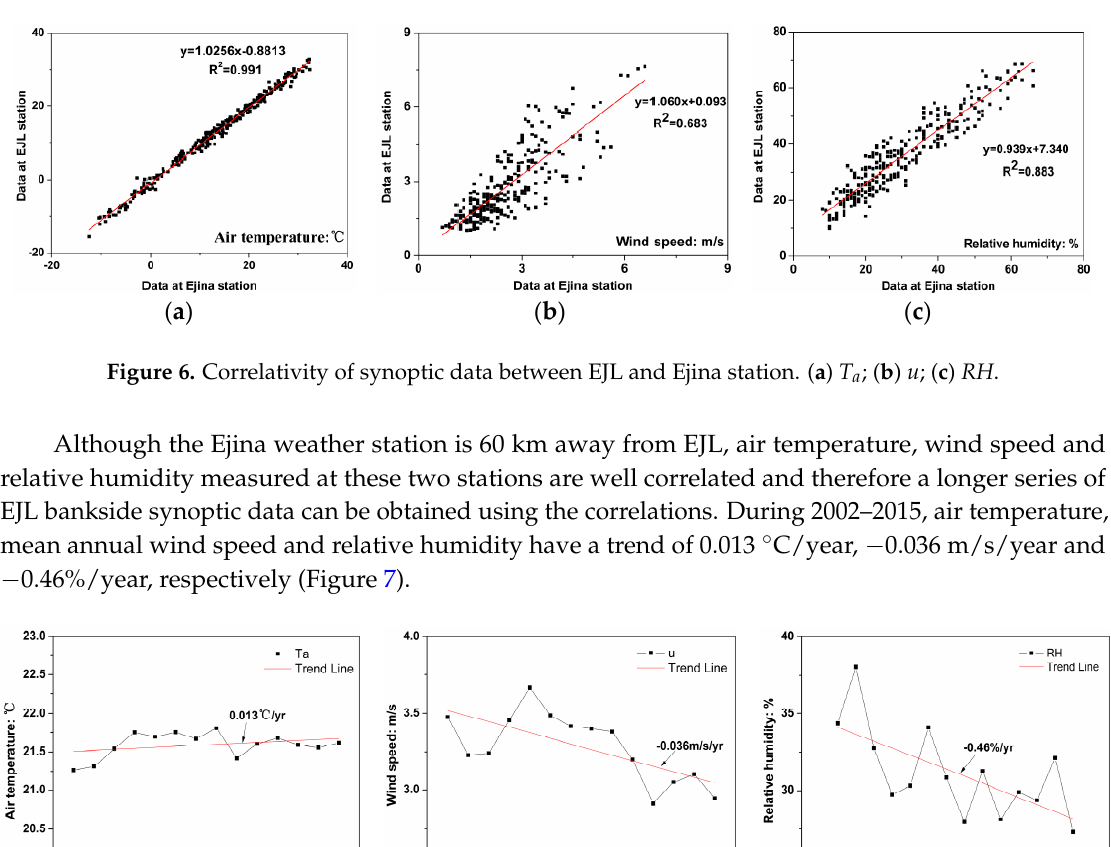
Figure 7. Mean annual variations of expanded governing synoptic factors of EJL. ( a ) T a ; ( b ) u ; ( c ) RH .